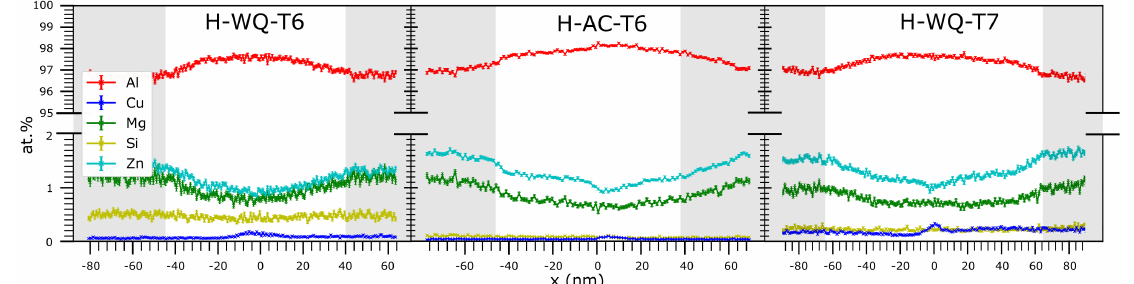
Figure 8. Elemental composition profiles across a type 3 grain boundary in three selected conditions. The width of the PFZs is indicated by the white area, and the ‘0’ position marks the location of the grain boundary core. The relative solute levels are similar, but the H-WQ-T6 condition exhibits a Zn/Mg ratio closer to one in addition to an enhanced Si